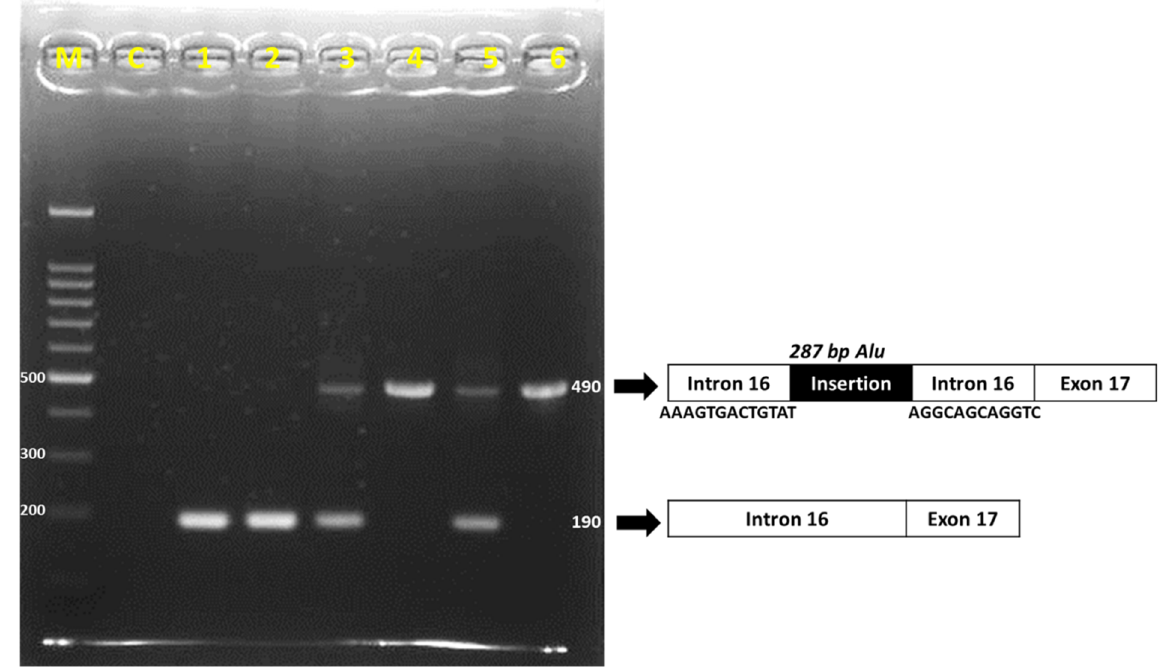
Figure 3. Electrophoresis of PCR-SSP products on 2% agarose gel. M = marker; C = negative control; 1 and 2 = DD genotype; 3 and 5 = ID genotype; 4 and 6 = II genotype.